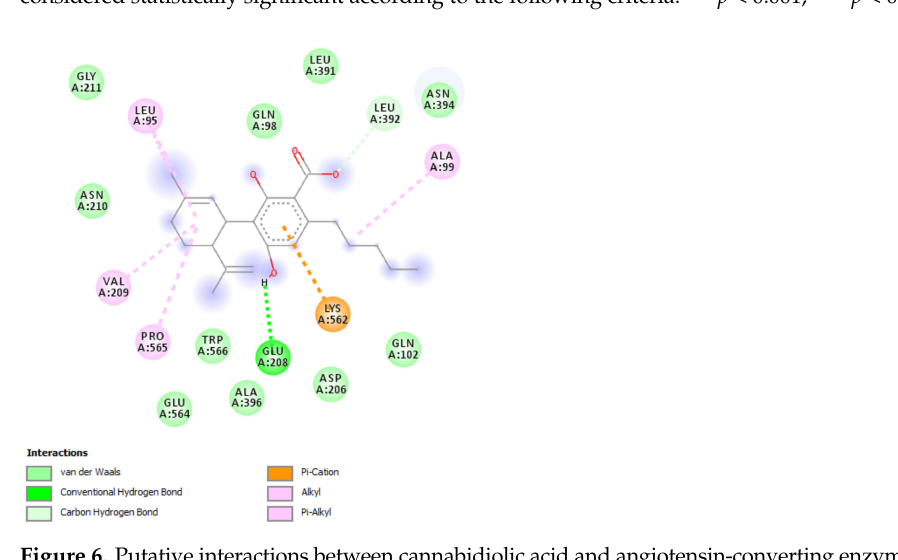
Figure 6. Putative interactions between cannabidiolic acid and angiotensin-converting enzyme 2 (ACE2; PDBID: 1R4L). Free energy of binding ( ∆ G) and affinity (Ki) are − 7.3 kcal/mol and 4.5 µ M,